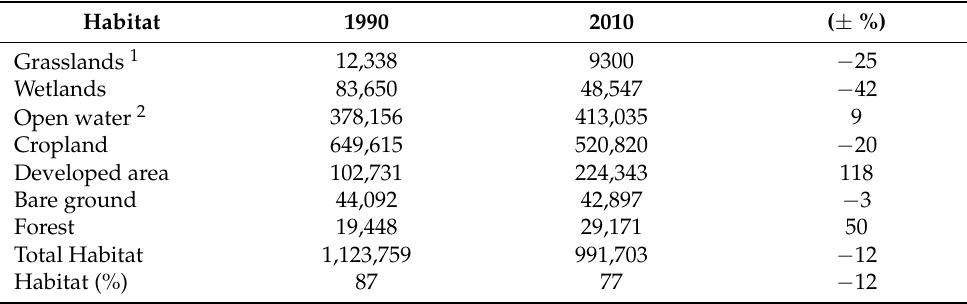
Table 6. Landcover changes within the 1990s Bohai Bay stopover sites. Habitat